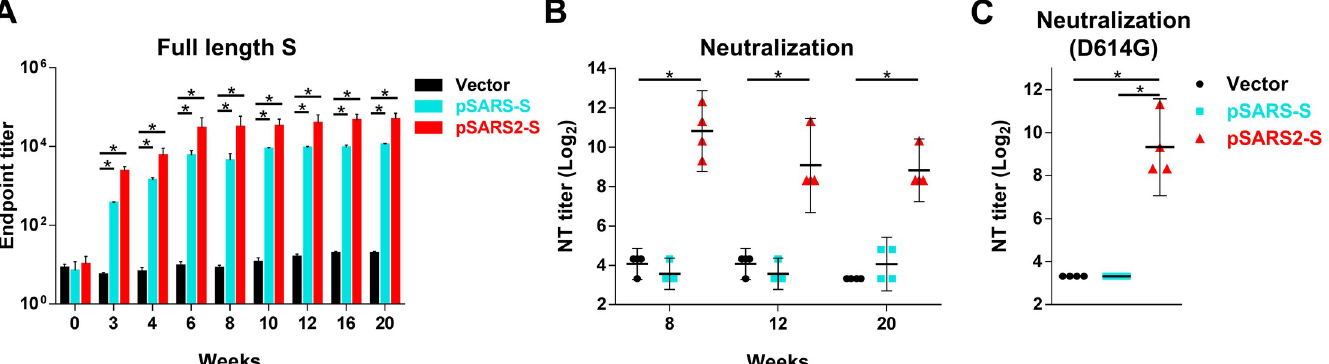
Fig 4. SARS-CoV-2 S DNA vaccine induced long-term humoral immunity and cross-protection against the SARS-CoV-2 with D614G mutation. BALB/c mice (n = 4 per group) were intramuscularly immunized three times at a 3-week interval with 100 μ g of vector, pSARS-S or pSARS2-S, followed by electroporation. Serum samples were collected at the indicated time points after the first immunization. (A) Antibodies against the SARS-CoV-2 full-length spike protein were evaluated by ELISA. (B, C) Vaccine-induced neutralizing activity against SARS-CoV-2 with D614 or G614 genotypes was evaluated by neutralization assay. Antibody titers are presented as the mean ± SEM, and neutralization titers are expressed as the geometric mean with a 95% confidence interval. � p < 0.05 by the Mann-Whitney test.